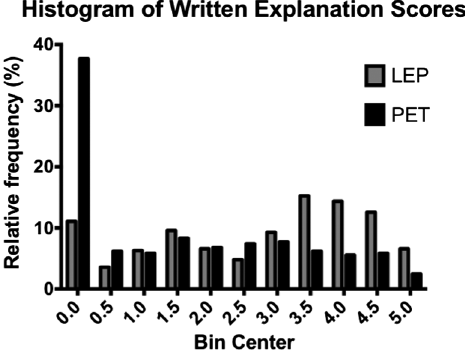
FIG. 6. Histogram of post-test written explanation scores for LEP ( N ¼ 334 ) and PET ( N ¼ 324 ) students.